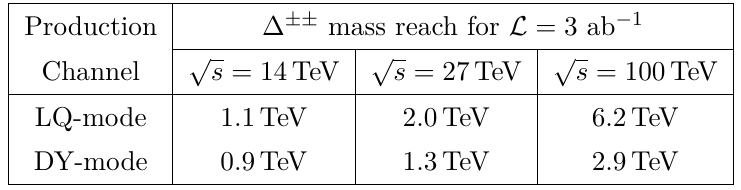
Table 5 . Comparison of the doubly-charged scalar mass reach in the LQ and DY modes (with same-sign di-muon pair final states only) for 3 ab − 1 integrated